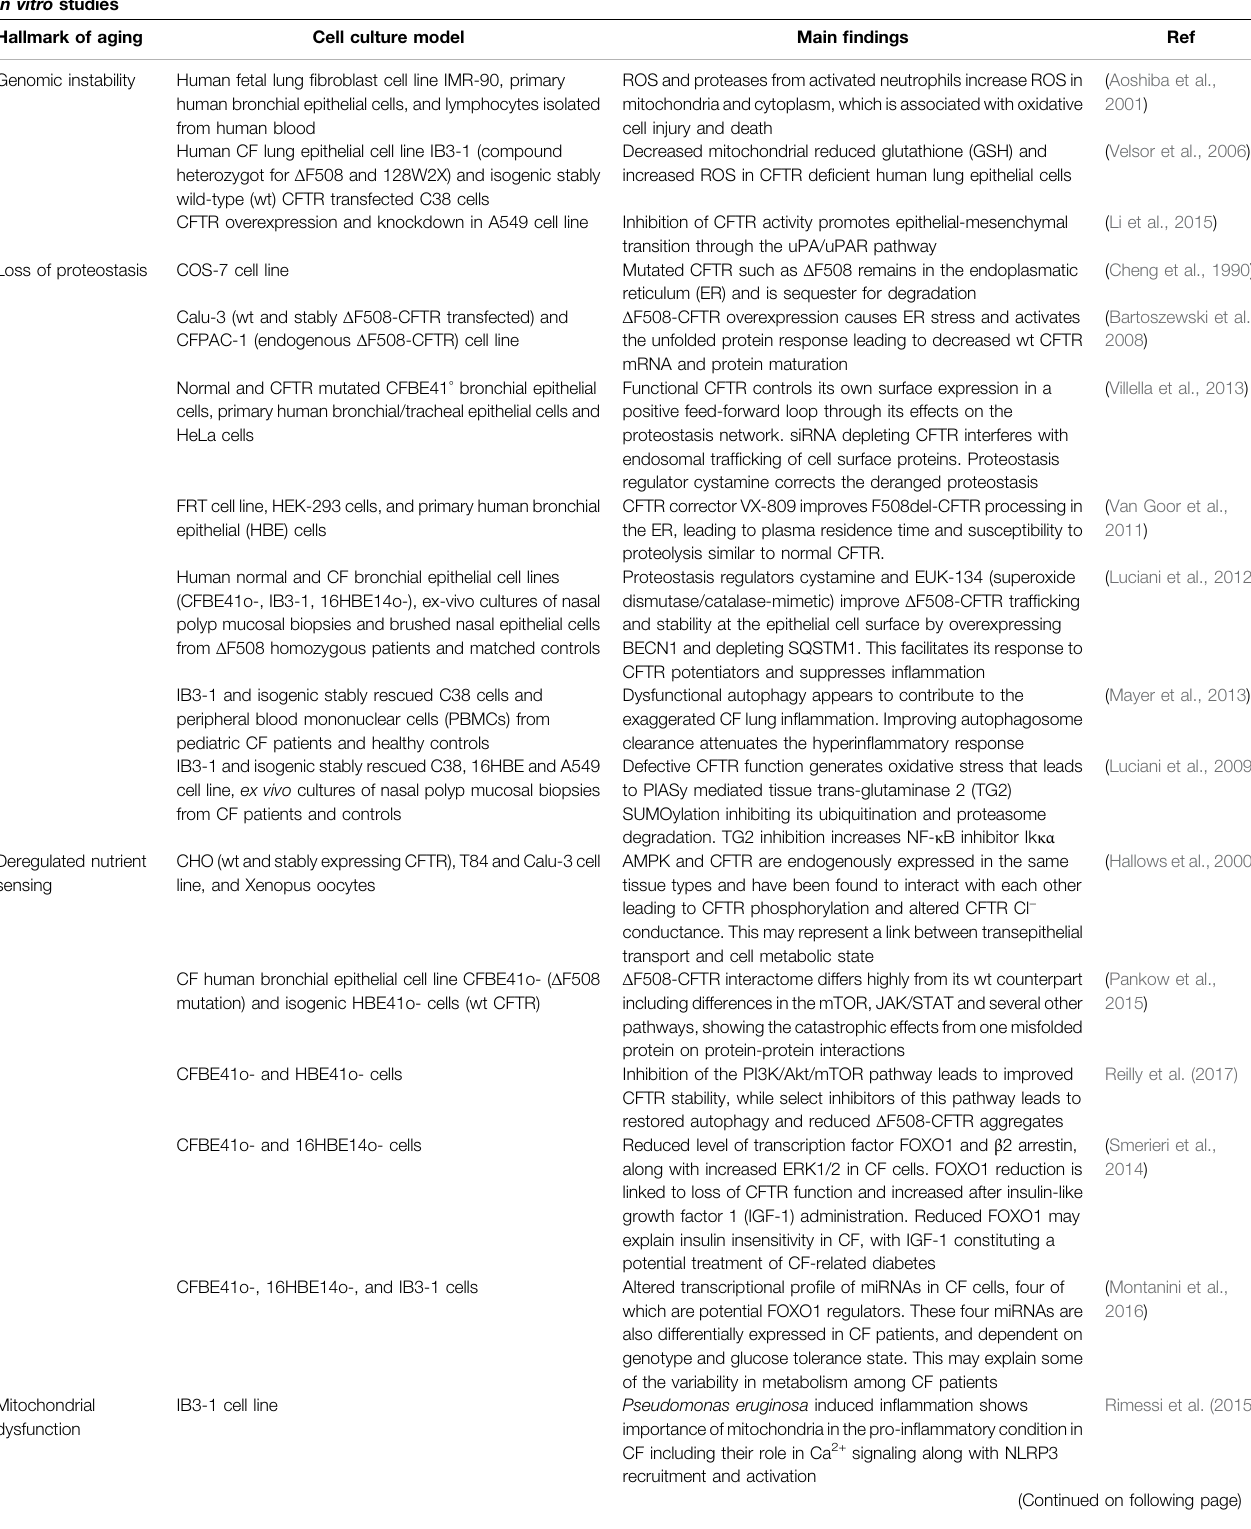
TABLE 1 | Summary of in vitro , animal and human studies pointing towards an involvement of accelerated aging in CF disease. In vitro